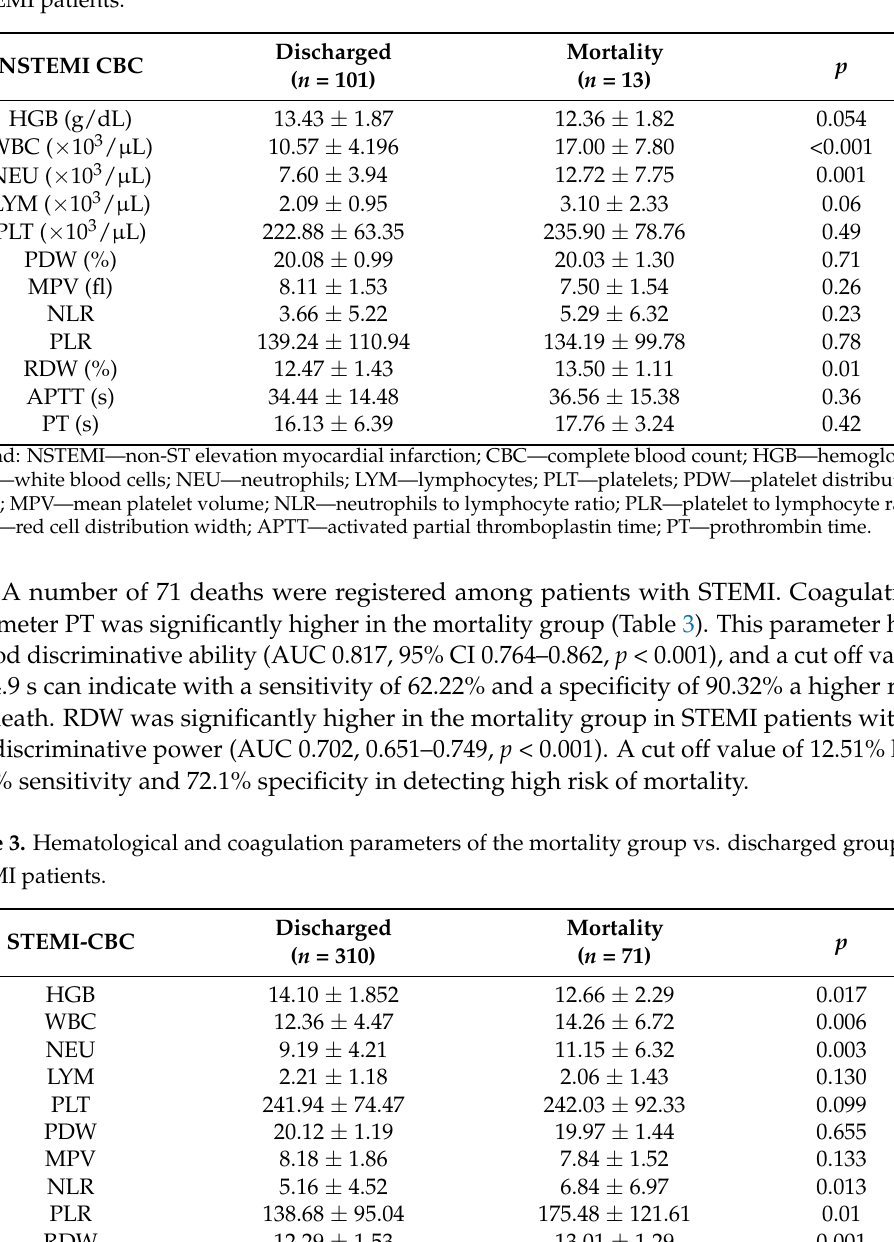
Table 2. Hematological and coagulation parameters of the mortality group vs. discharged group in NSTEMI patients.